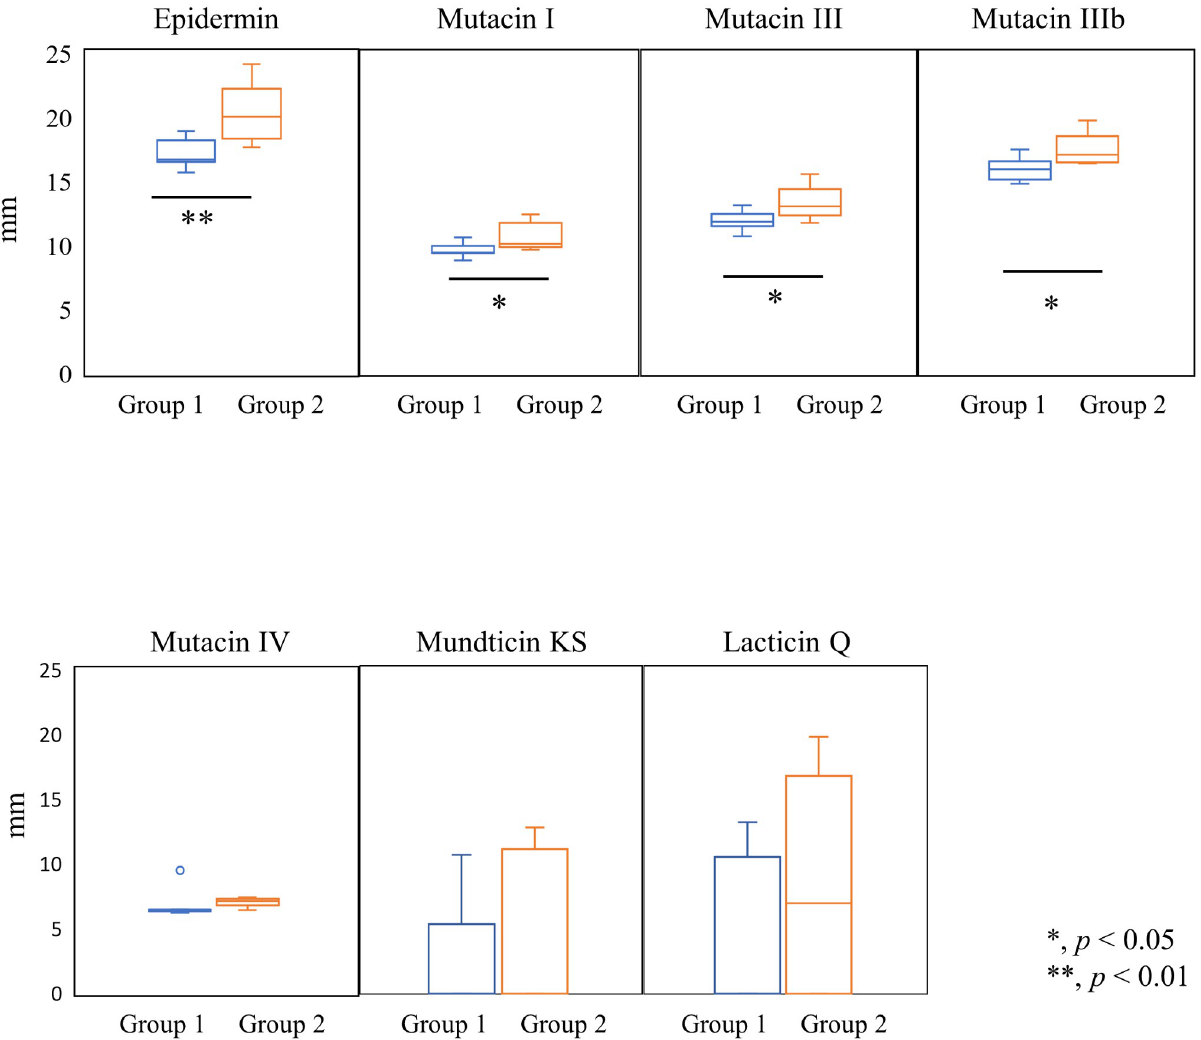
Fig 3. Comparison of susceptibility to epidermin, and mutacin I/II/III in Groups 1 and 2. The distribution of the inhibitory zones (diameter: mm) are shown. Student’s t test was used to determine significant differences between the Group 1 and Group 2 C . difficile strains.